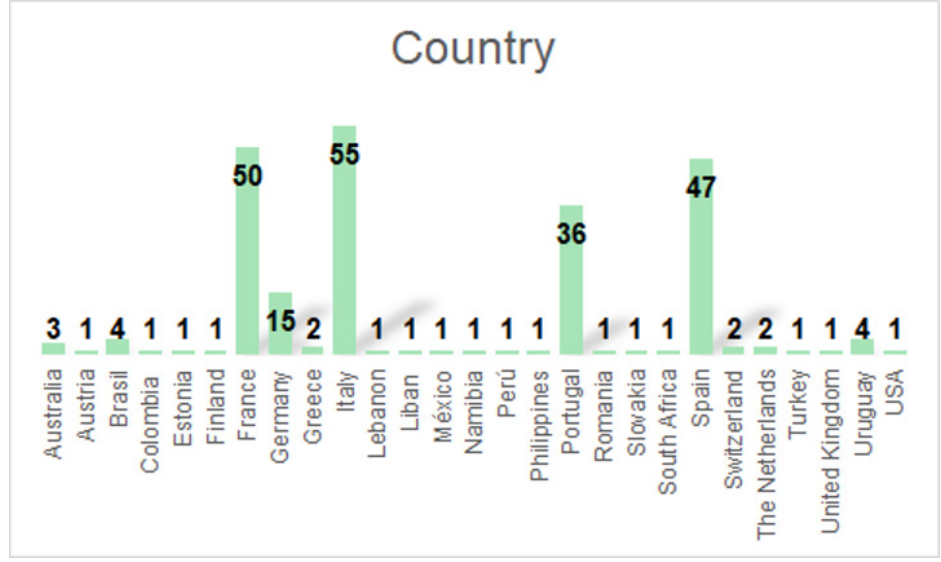
Figure 7. Nationalities of the 236 active MOOC participants.